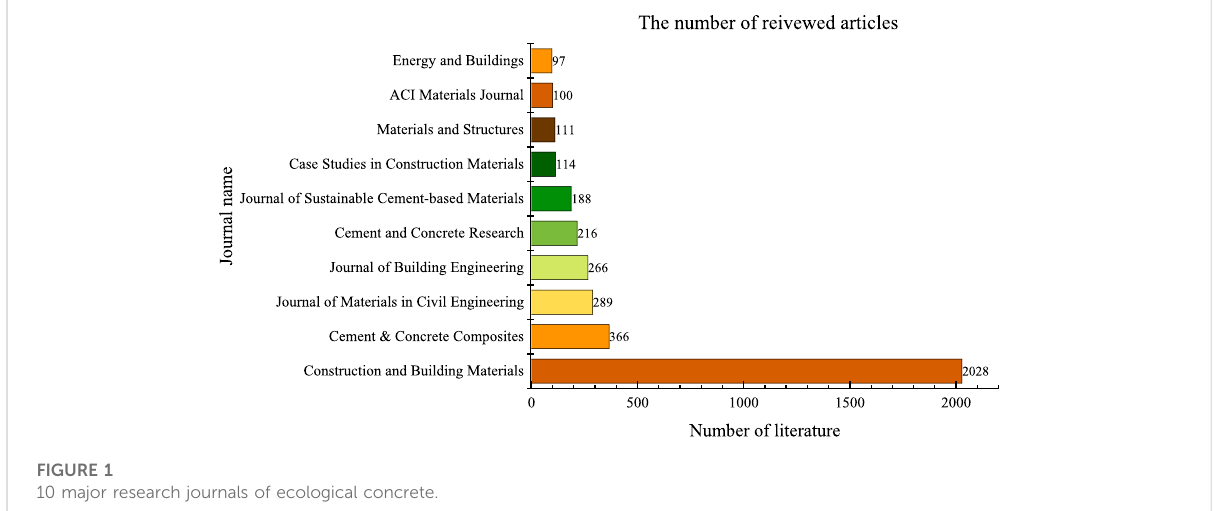
FIGURE 1 10 major research journals of ecological concrete.